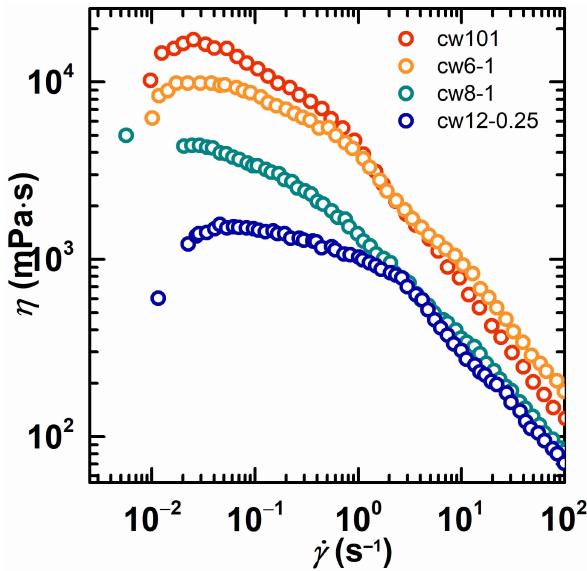
Figure 7. The apparent viscosity as a function of the shear rate for cw101 and HAPAM with different alkyl chains. The copolymer concentration was fixed at 2 wt% in all